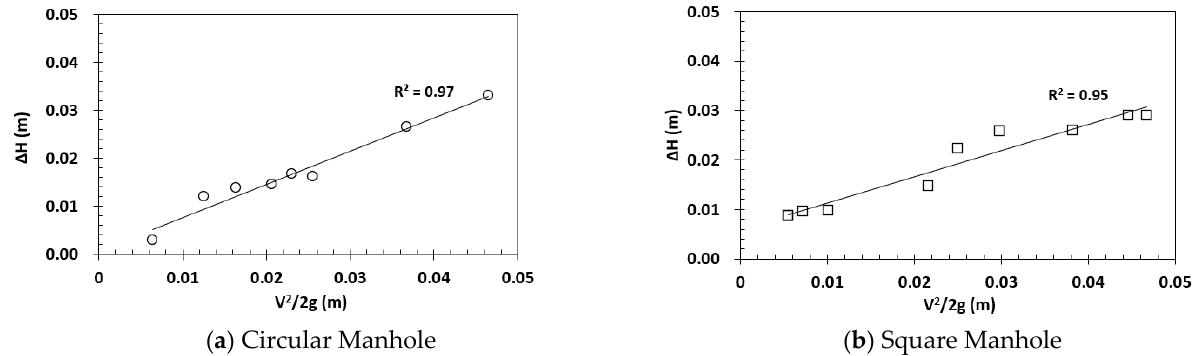
Figure 5. Relationship between Head Loss ( Δℎ ) and Velocity Head ( 𝑉 (cid:2870) /2𝑔 ) Table 1. Head loss coefficient for surcharge